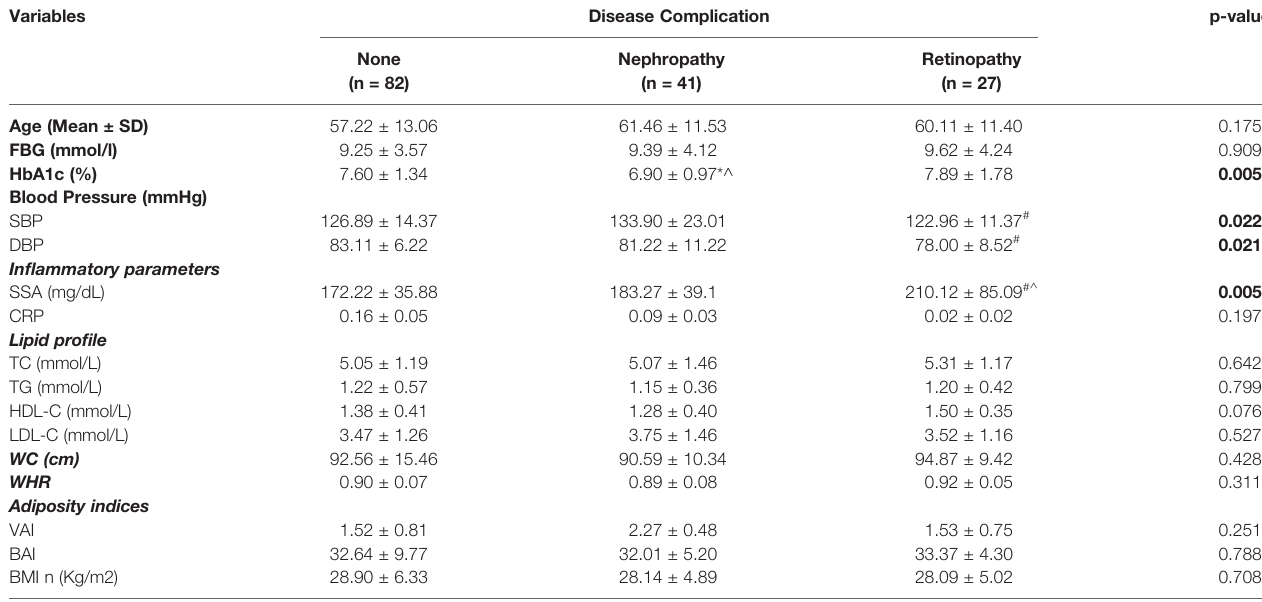
TABLE 2 | Glycaemic indices, in fl ammatory markers, lipid pro fi le, obesity and anthropometric indices among the T2DM patients strati fi ed by disease complications.